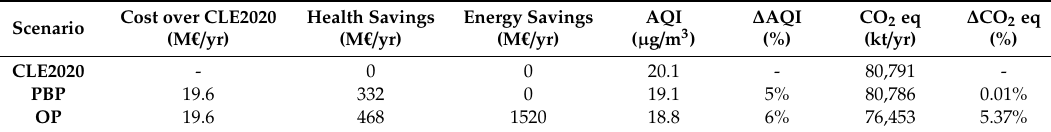
Table 3. Impacts of the scenarios analyzed with respect to CLE2020 in terms of health, costs and savings, Air Quality Index, and greenhouse gases (GHG) emissions.